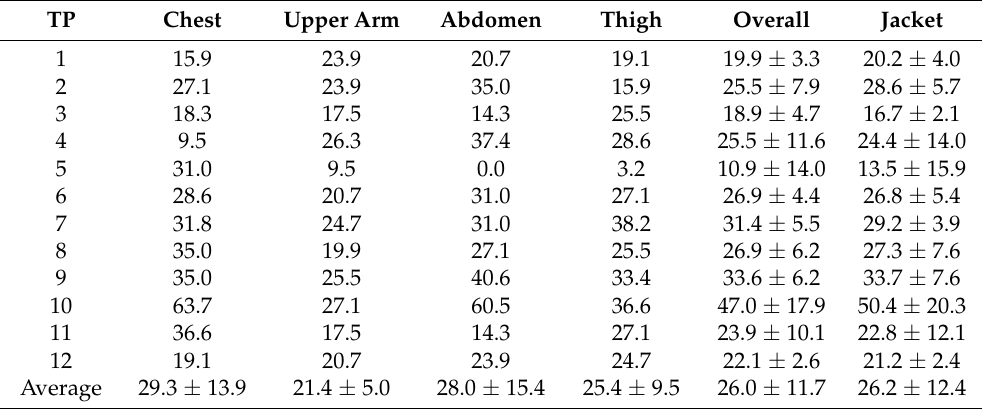
Table 6. Air gap between body and clothing estimated at four different body locations in mm. The overall air gap is the mean of the air gaps of all body locations including the standard deviation. The air gap of the jacket is the mean air gap of the chest, upper arm, and abdomen including the standard deviation.